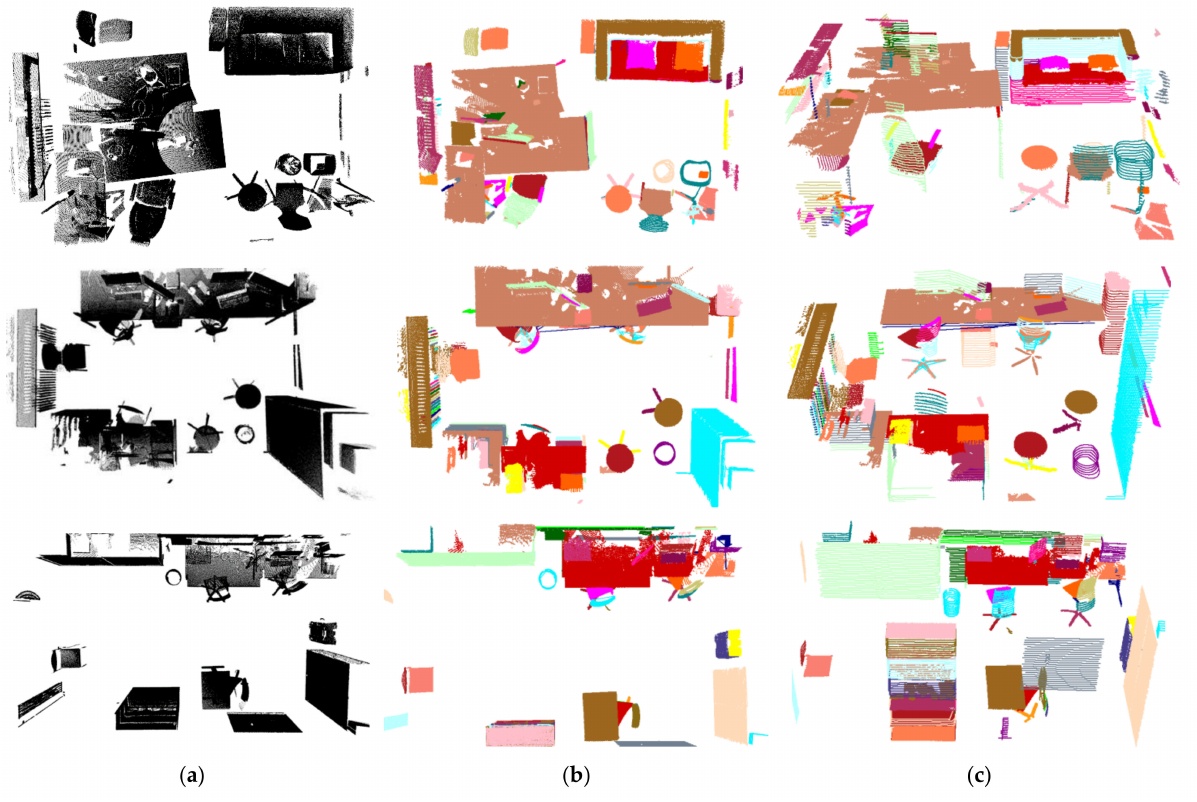
Figure 11. Experiment results of ETH scenes, different colors denote the components of indoor scenes: